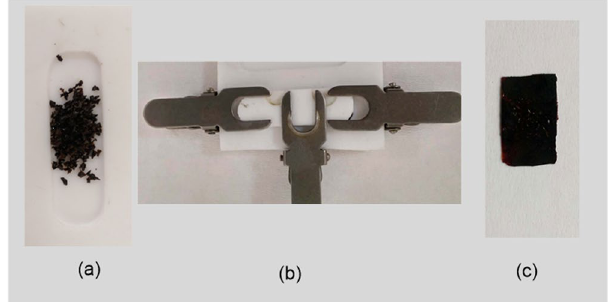
Figure 7. Image of chopping and 5 th recycling of PPOB 40 -B-al 40 -S 20 . Chopped sample ( a ), molding ( b ), after thermal treatment ( c ).